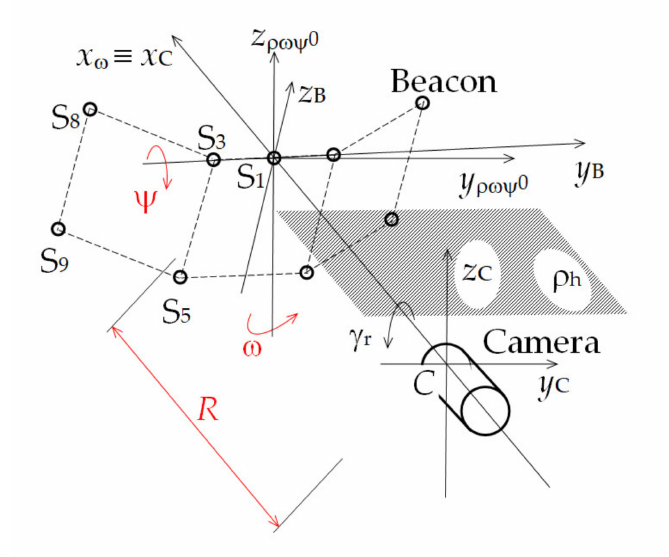
Figure 2. Diagram of the measuring